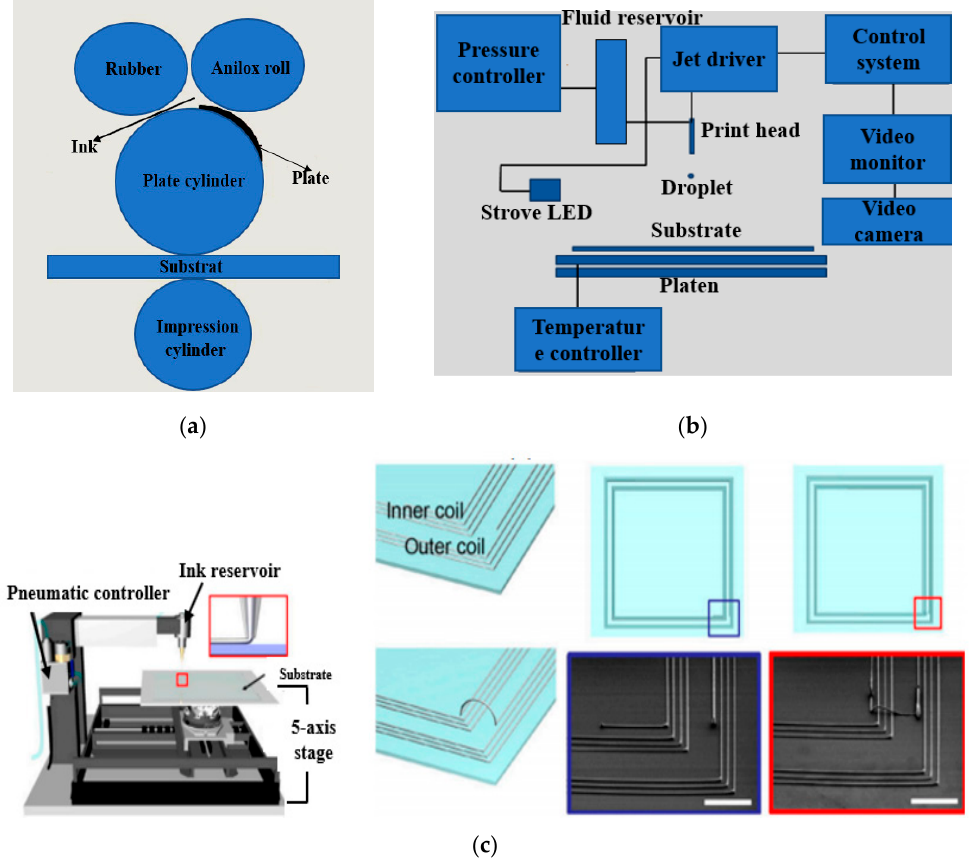
Figure 5. ( a ) Flexography printing process [207], ( b ) inkjet printing process [177], and ( c ) 3D direct ink writing method [116]. writing method [116]. Table 6. Comparison of di ff erent inkjet or direct ink writing methods Table 6. Comparison of different inkjet or direct ink writing methods [208] .